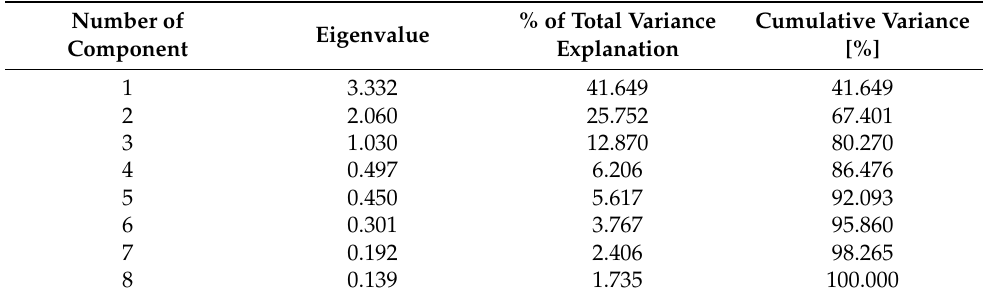
Table 2. Originally determined principal components with matrix eigenvalues and percentage of variance explained.